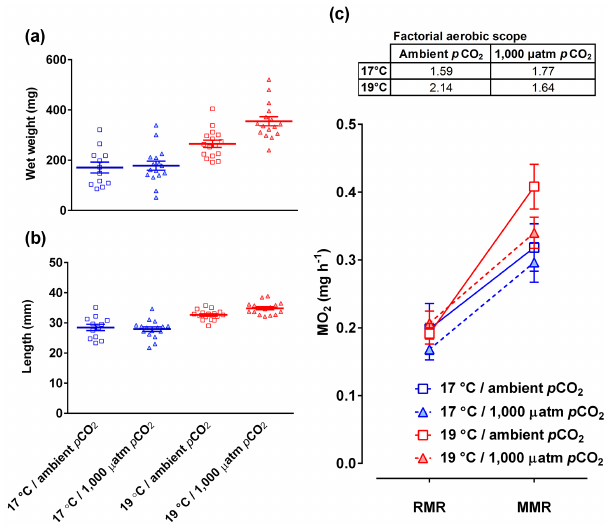
Fig. 5. (a) Wet weight and (b) total length of juvenile ( d 67–69 post-hatch) D. labrax used in the metabolic rate study. Horizontal lines are means and error bars are ± 1SEM, N =12–16. (c) Rou- tine metabolic rates (RMR) and maximal metabolic rates (MMR) of juvenile D. labrax ( d 67–69 post-hatch) grown under each exper- imental condition. Mean values ± 1SEM, N =12–16. See Table 1 for details on each experimental